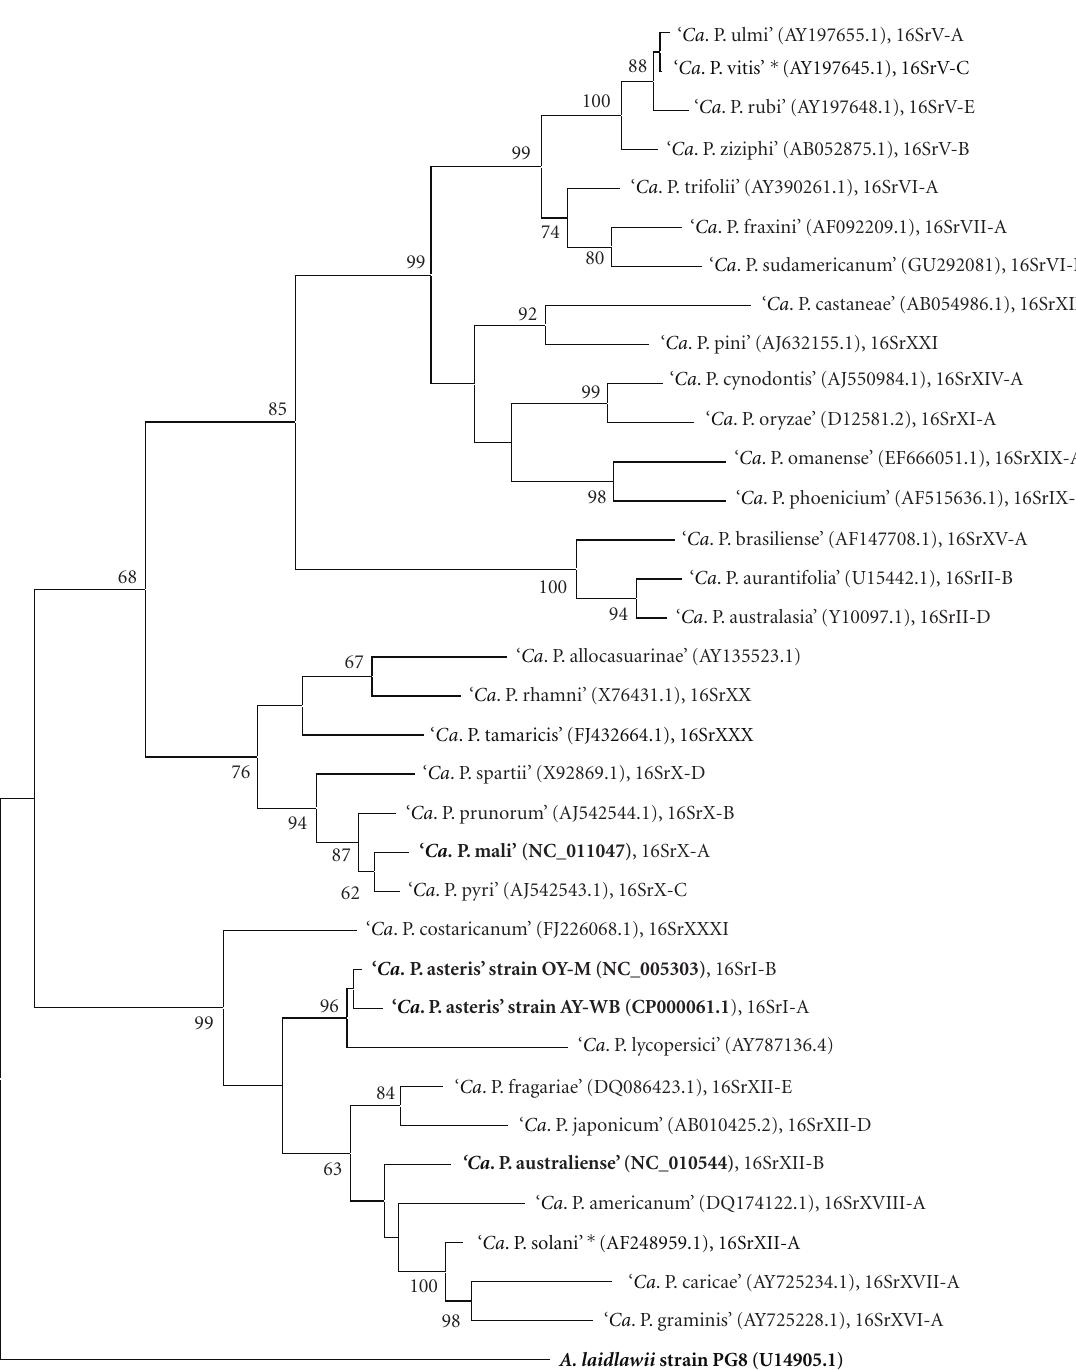
Figure 1: Phylogenetic tree constructed by parsimony analyses of 16S rDNA sequences of 34 phytoplasma strains, belonging to all ‘ Candidatus Phytoplasma’ species described employing A. laidlawii as outgroup. The completely sequenced strains are in bold. CLUSTAL W from the Molecular Evolutionary Genetics Analysis program-MEGA5 [26] was used for multiple alignment. The maximum parsimony tree was obtained using the Close-Neighbour-Interchange algorithm, implemented in the MEGA5, with search level 3 in which the initial trees were obtained with the random addition of sequences (10 replicates). One of nine equally parsimonious trees is shown in Figure 1. Numbers on the branches are bootstrap values obtained for 2000 replicates (only values above 60% are shown). GenBank accession numbers are given in parentheses, and 16Sr group classification (when available) is shown on the right side of the tree. Asterisk indicates ‘ Candidatus Phytoplasma’ proposed by the IRPCM Phytoplasma/Spiroplasma Working Team—phytoplasma taxonomy group [5], not yet formally described. The tree is drawn to scale with branch lengths calculated using the average pathway method and represents the number of changes over the whole sequence. The scale bar represents 20 nucleotide